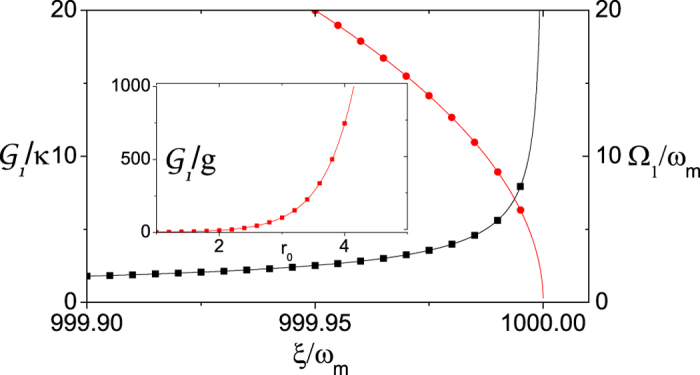
The radiation pressure coupling strength , and the Bogoliubov mode frequency Ω1 versus the system parameter ξ.The relevant parameters are Δ1 + Δ2 = 2000ωm, g = 0.001ωm, and κ = 0.02ωm. In the inset  versus the squeezing parameter r0.